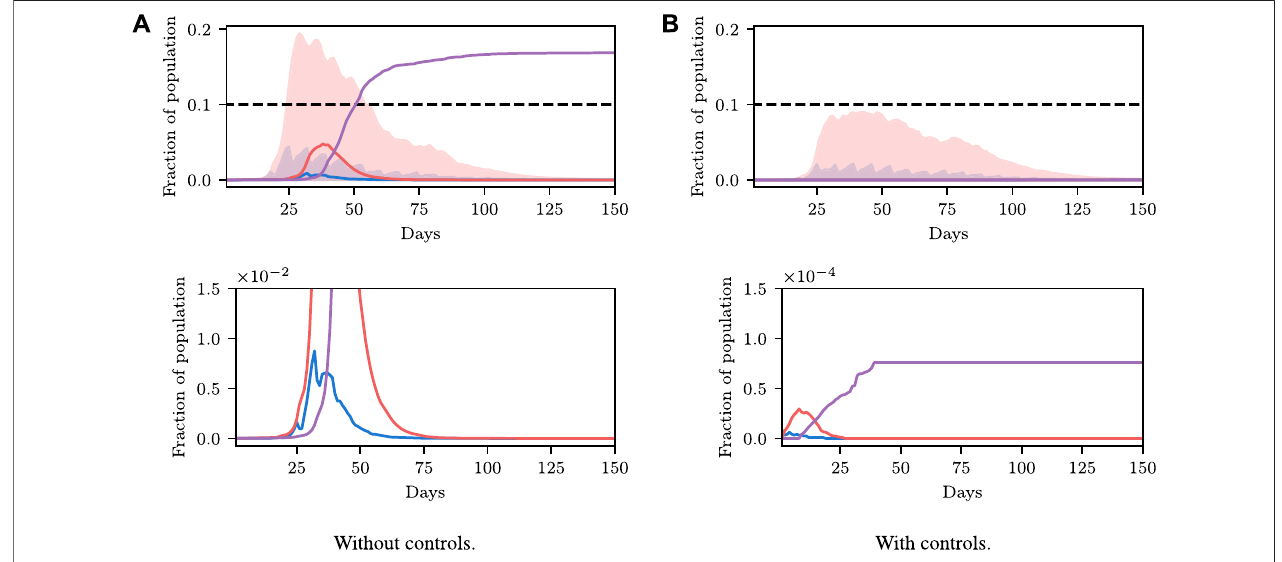
FIGURE7| AggregatedSEIRstatisticsextractedfrom100,000FREDsimulationsofanin fl uenza(notCOVID-19)outbreakinAlleghenyCounty.Theobjectiveinthis scenario is to keep the number of infectious people (I in SEIR terminology, shown here in red) below 10 % , indicated by the black dotted line. We plot the median and con fi dence intervals between the 3rd and 97th percentiles, shown by the shaded areas. To avoid clutter and focus on relevant dynamics, the susceptible statistic (S in SEIR terminology, shown previously in green) and con fi dence intervals for the Recovered (R in SEIR terminology, shown here in purple) statistic are omitted. Blue shows the fraction of the population that has been exposed (E in SEIR terminology). The bottom row shows a zoomed-in version of the top row, where all con fi dence intervalshavebeenremoved,foreaseofvisualinspection. (A) showstheevolutionoftheoutbreakwhen nocontrolsareapplied. (B) showstheevolutionoftheoutbreak when controls, solved for using our method, are applied. When no controls are applied we see the number of infectious people often exceeds the allowable threshold, whereas, when optimal controls are applied, the con fi dence interval for infectious people (red) stays below our